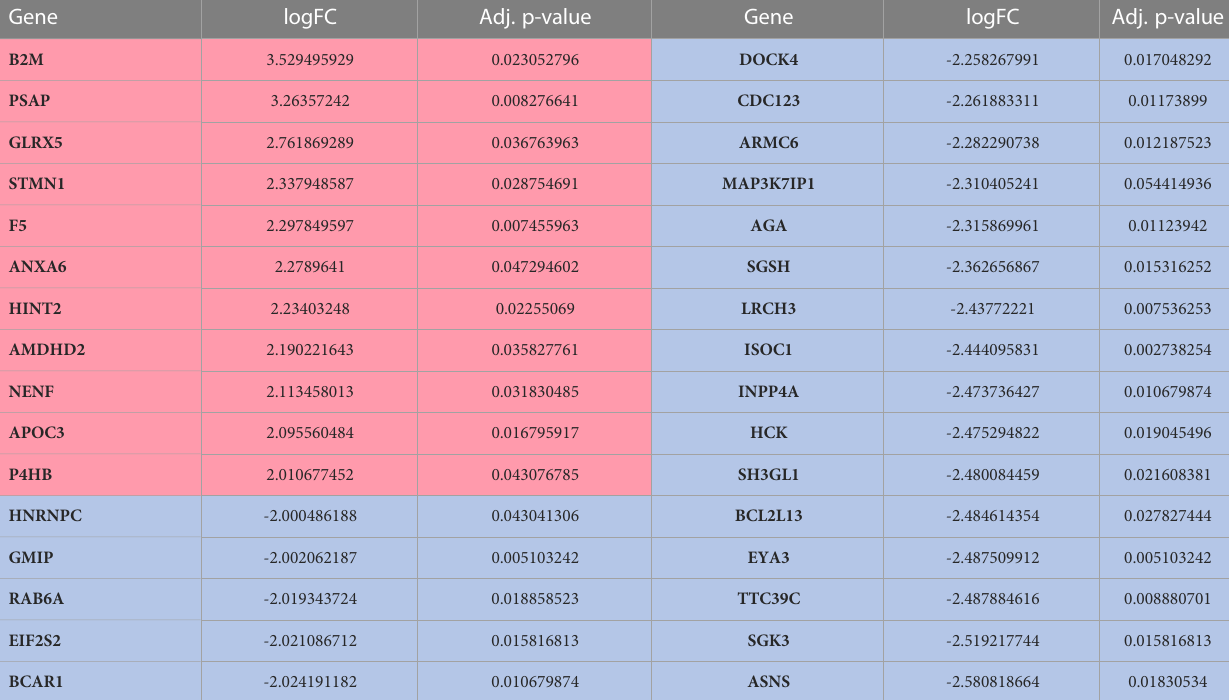
TABLE 1 Signi fi cantly (> 2 logFC) expressed proteins in PHX treated M1 macrophages. Gene